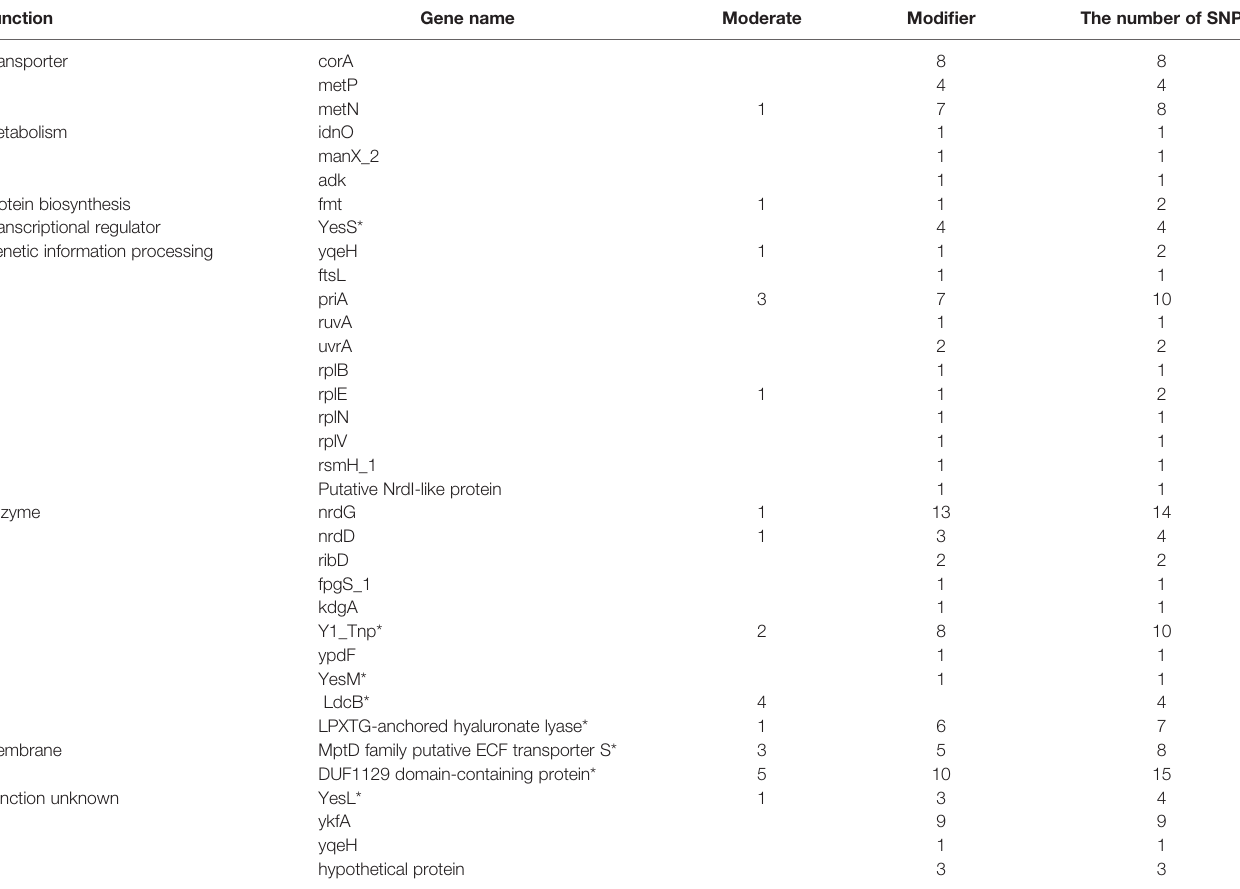
TABLE 1 | Genes with mutations that are unique to ST558 from